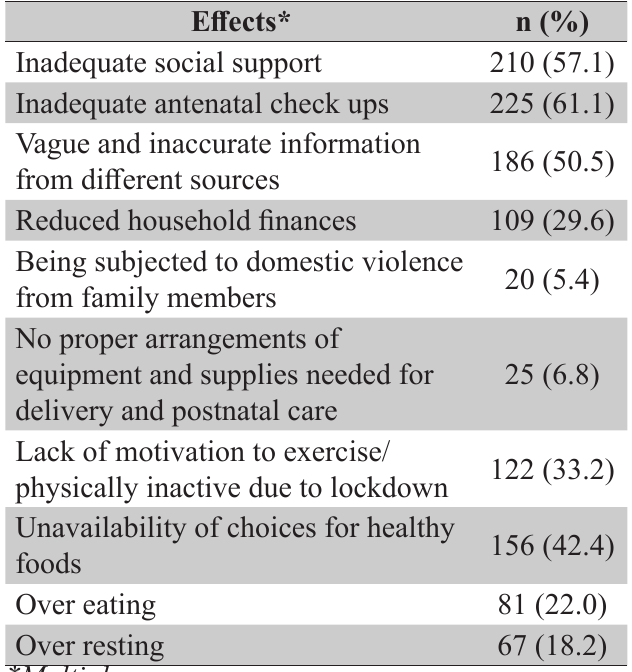
Table 2: COVID-19 related effects experienced by the participants